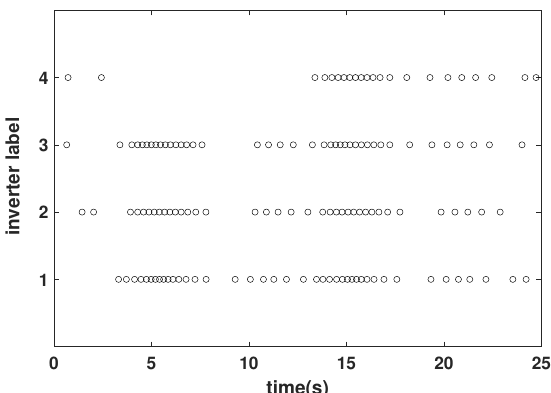
Figure 12. Triggering time instants under event-triggered condition (42) in Case B.